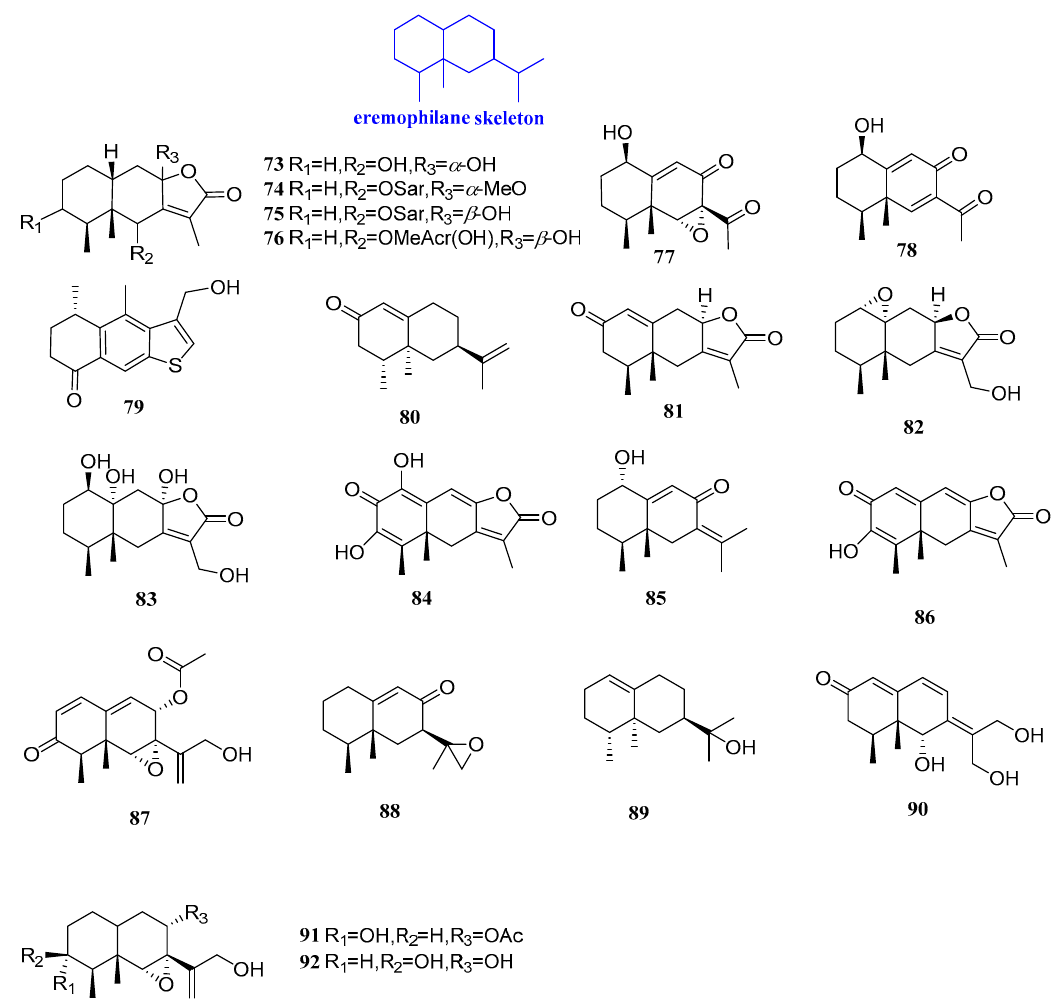
Figure 6. Structures of eremophilane-type sesquiterpenoids 73 – 92 . Leptosphin A ( 79 , Figure 6) was purified from the solid fermentation cultures of the endophytic fungus Leptosphaeria sp. XL026, isolated from the leaves of Panax notoginseng . The antibacterial and antifungal activities of compound 79 were tested. The results showed that compound 79 had antifungal activity against Fusarium graminearum ( F. graminearum ), S. sclerotiorum , V. dahliae Kleb, B. carbonum Wilson, P. parasitica Dastur, A. alternata (Fries) Keissler, and B. cinerea Pers, with the MIC value range of 25–100 µ g/mL. Furthermore, compound 79 also showed medium antibacterial activity against Micrococcus lysodeikticus ( M. lysodeikticus ), B. cereus , S. aureus , S. typhimurium , and E. aerogenes , with MIC values of 50, 25, 100, 100, and 50 µ g/mL, respectively [43]. Nootkatone ( 80 , Figure 6) exists in grapefruit and has a variety of pharmacological effects. Researchers found that 80 had an inhibitory effect at the concentrations of 1 and 0.5 mM, respectively, for L. monocytogenes and C. diphtheriae [44]. Xylareremophil and eremophilane mairetolides B and G ( 81 – 83 , Figure 6) were iso- lated from the endophytic fungus Xylaria sp. GDG-102, cultured from Sophora tonkinensis. For P. vulgaris and Micrococcus luteum ( M. luteum ), 81 displayed moderate activity, with the same MIC value of 25 µg/mL, and the MIC values of 83 were 25 µg/mL and 50 µg/mL, respectively. Compound 81 was found to be active against M. luteum with a MIC value of 50 µg/mL. Compounds 81 – 83 showed inhibitory effects on both B. subtilis and M. lysodeik- ticus , with a same MIC value of 100 µg/mL [45].